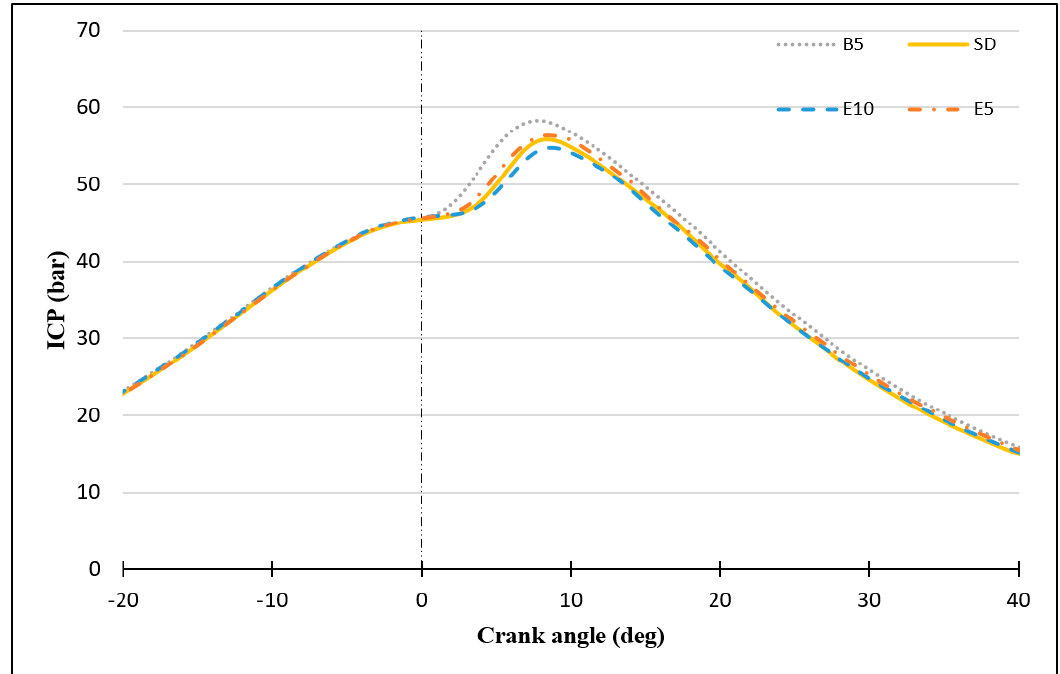
Figure 10. In-cylinder pressure traces for B5, E10, E5, and SD at 2 kW.